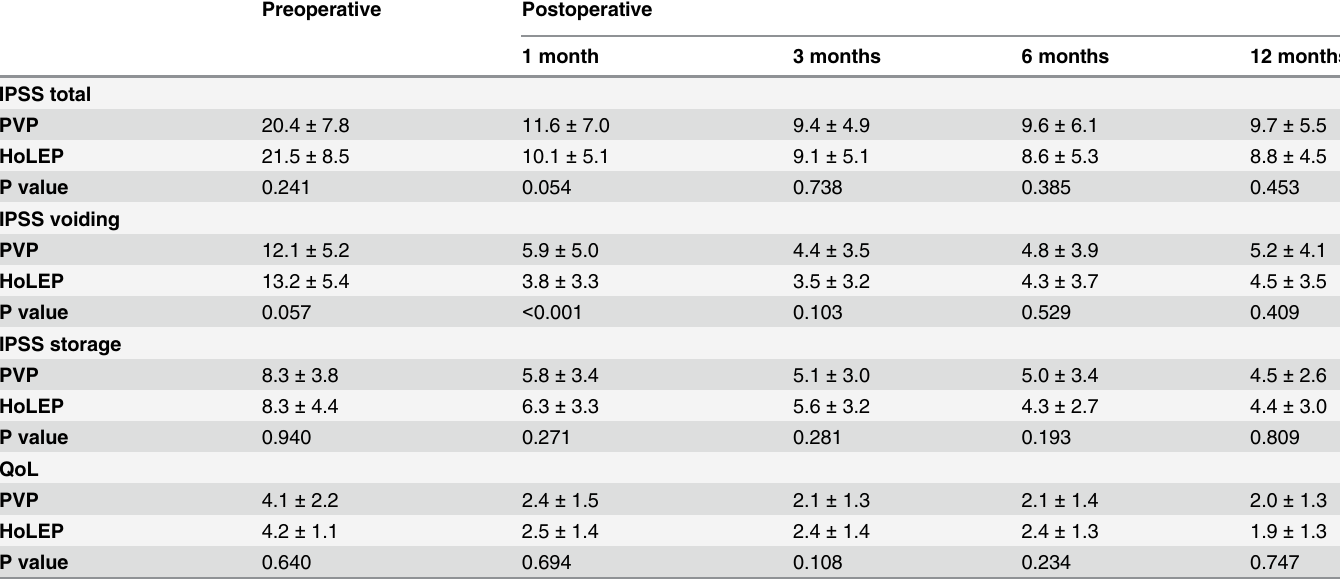
Table 3. Follow-up data of up to 12 months after PVP or HoLEP.